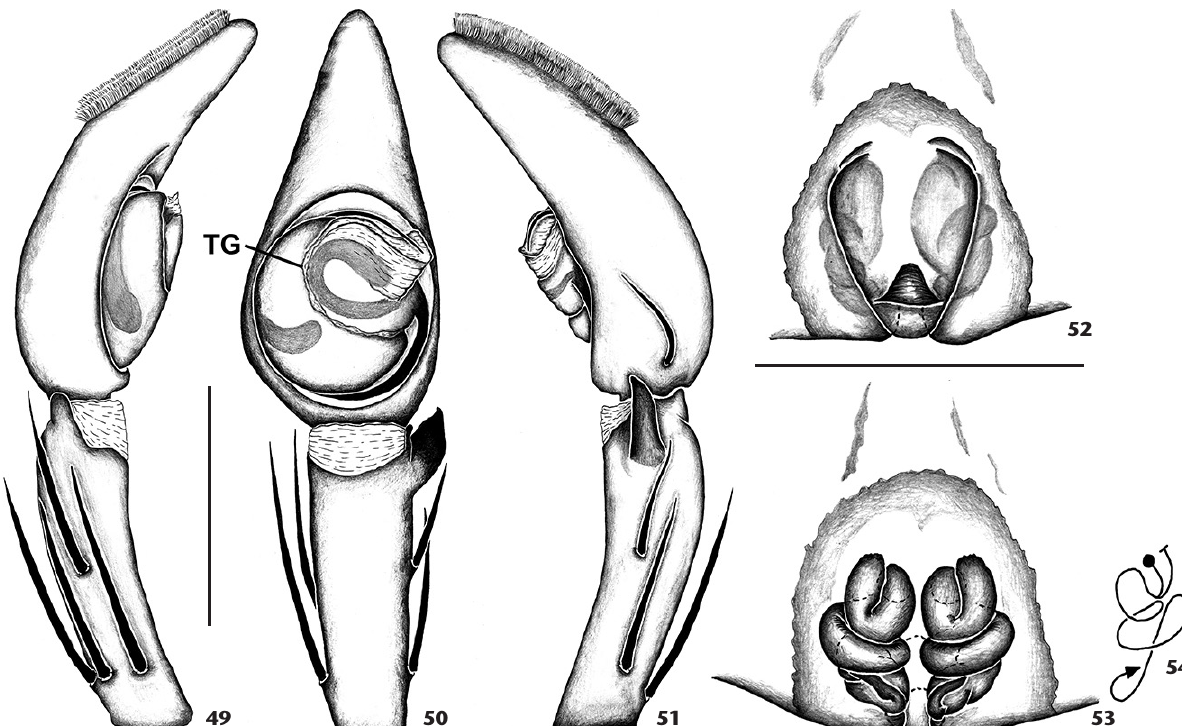
Figures 49-54. Nungara niveomaculata (Mello-Leitão, 1941) comb. nov. 49-51 male, IBSP 17956, left palp (49) prolateral view; (50) ventral view; (51) retrolateral view. 52-54 female, IBSP 39305 (52) epigyne, ventral view; (53) vulva, dorsal view; (54) schematic course of internal duct system (TG = tegular groove). Scale bars: 1